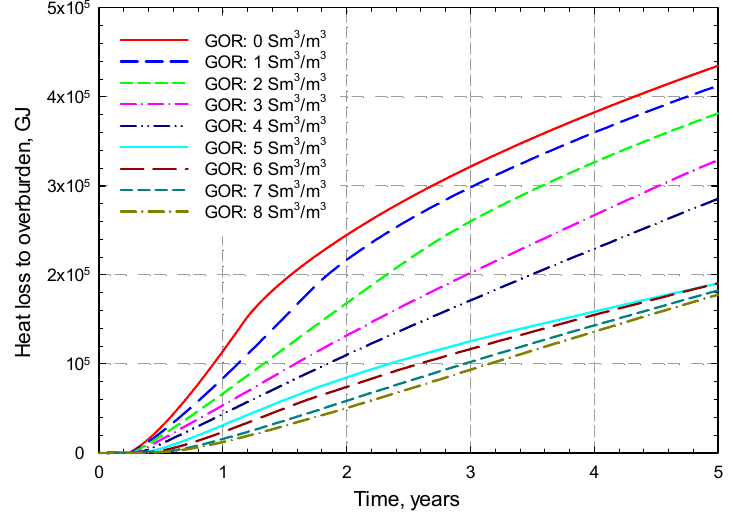
Figure 5. Comparison of the heat loss to the overburden with different initial gas oil ratios (GORs) in the reservoir ranging from 0 to 8 Sm 3 /m 3 .